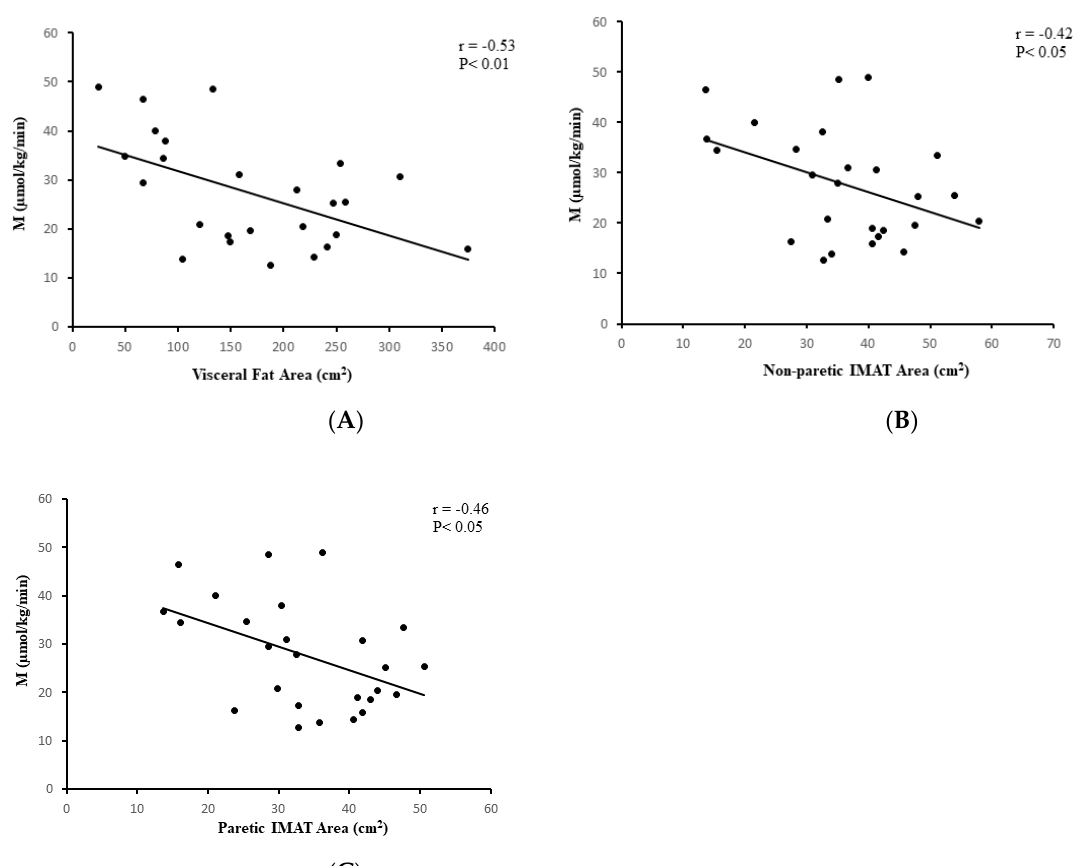
Figure 3. Correlation analysis with body composition. ( A ) Relationship between visceral fat area and glucose utilization (M) in stroke participants ( n = 25; r = − 0.53, p < 0.01); ( B ) Relationship between nonparetic intermuscular fat (IMAT) area and glucose utilization (M) in stroke participants ( n = 26; r = − 0.42, p < 0.05); ( C ) Relationship between paretic intermuscular (IMAT) fat area and glucose utilization (M) in stroke participants ( n = 26; r = − 0.46, p < 0.05).